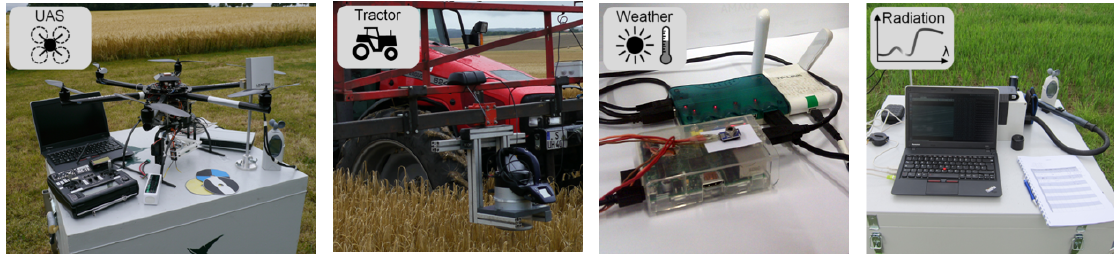
Figure 2. Overview of the sensor systems involved in the sensor layer. From left to right: Hexe (unmanned aircraft system (UAS)), Multiplex fluorescence sensor (tractor), HYT221 weather sensor (weather) and HandySpec Field spectrometer with base station